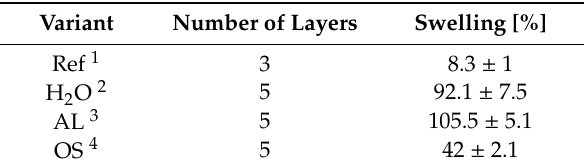
Table 4. E ff ect of densification and chemical treatments on the thickness swelling behavior of spruce plywood samples after complete immersion in 20 ◦ C deionized water for 24 h. ( n = 5 for Ref; n = 5 for H 2 O; n = 5 for AL; n = 5 for OS).